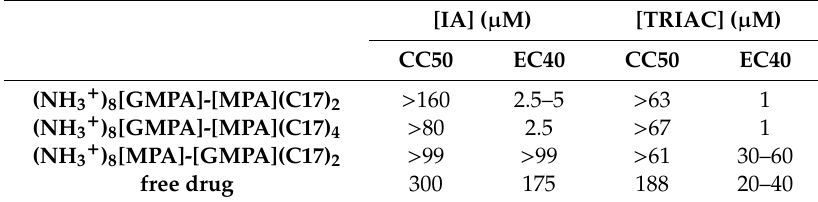
Table 3. CC50 and EC40 values for the dendrimer / drug aggregates compared to free drug